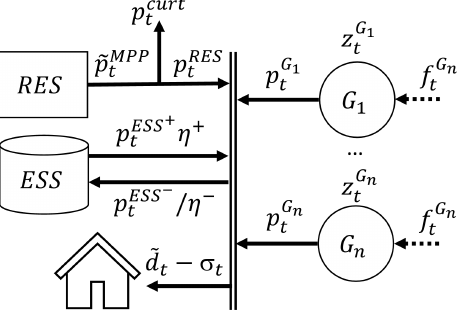
Figure 2. Hybrid microgrid single-node representation, and representation of operating